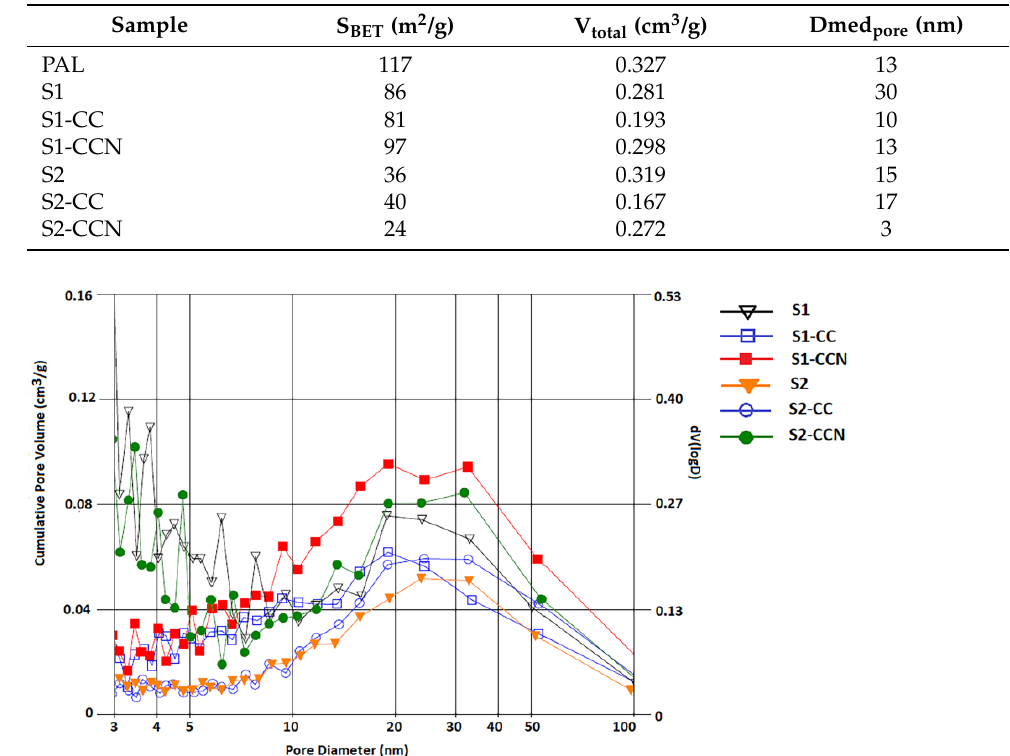
Figure 5. Pore-size distribution of the hybrid